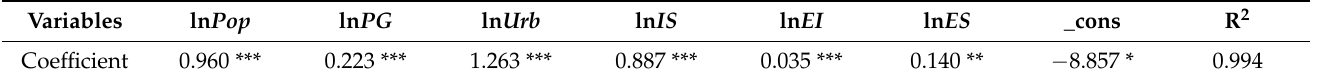
Table 4. Influencing factor coefficient of carbon emissions in